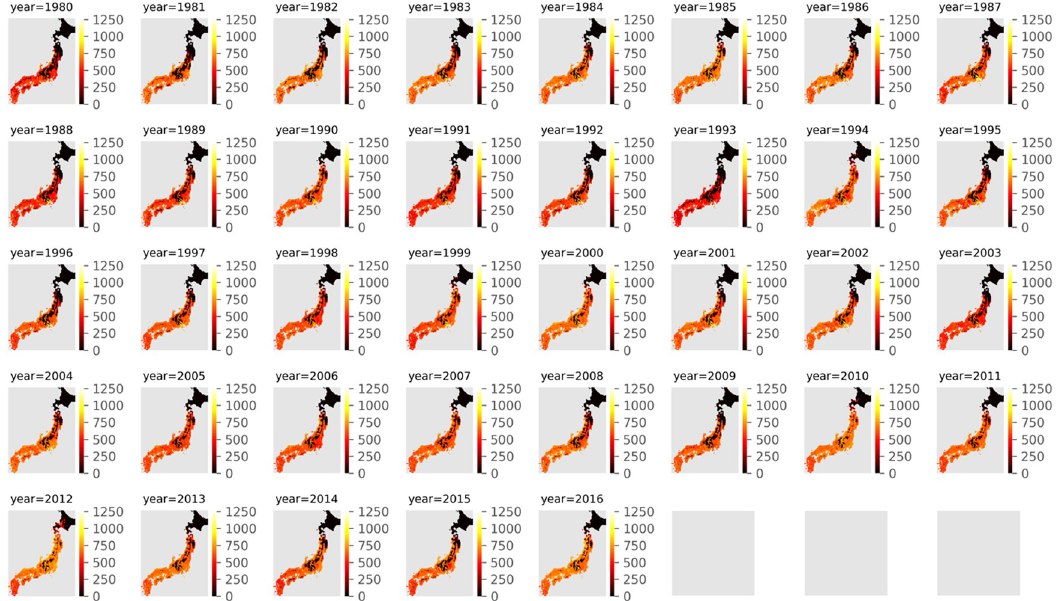
Fig 1. Heatmap of the grain yield simulated by SIMRIW. In northern areas of Japan, DV I does not reach 2.0 because of cold temperatures; hence, the grain yield is considerably low.